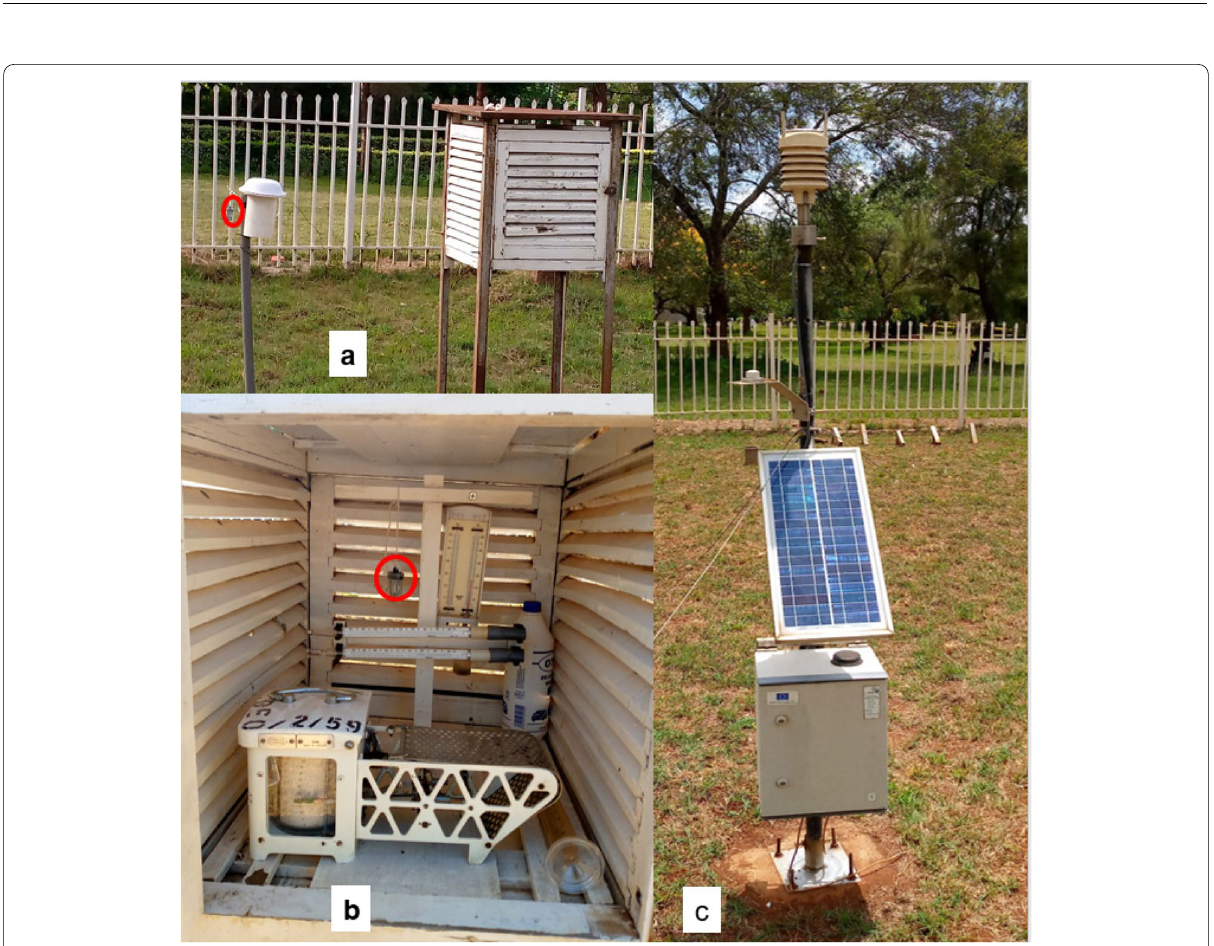
Fig. 2 The experimental set-up at Kenyatta University weather station; a – unshielded and shielded (in a fabricated radiation shield), b – a HOBO Pendant logger inside the Stevenson screen, and c – automatic weather station (model Envilog GP5W-Shell sensor, ecoTech, Germany). The HOBO Pendant logger are indicated by the red